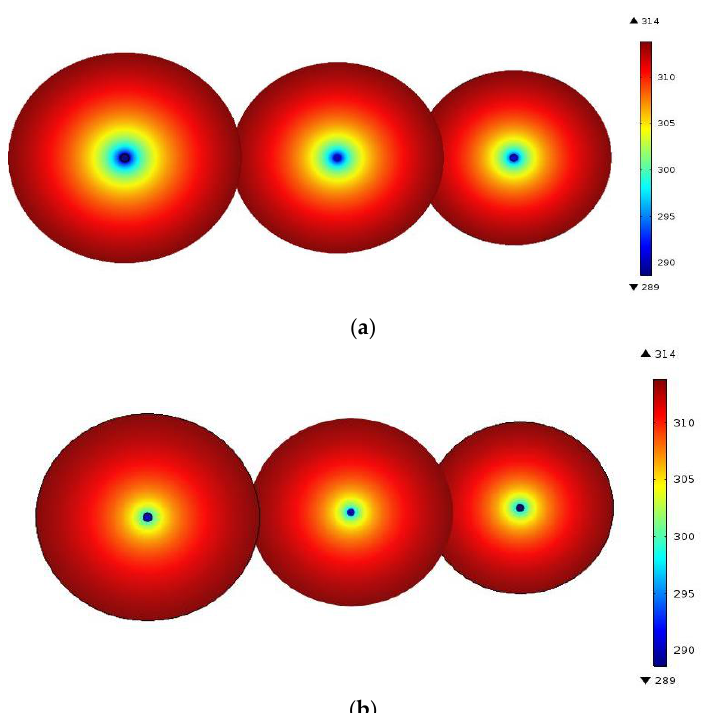
Figure 8. Comparison of effects of thermal insulation of support materials (longitudinal section): ( a ) Nephogram of the temperature field of the roadway supported using common sprayed concrete; ( b ) Nephogram of the temperature field of the roadway supported by using the new heat-insulating materials with basalt fibres.